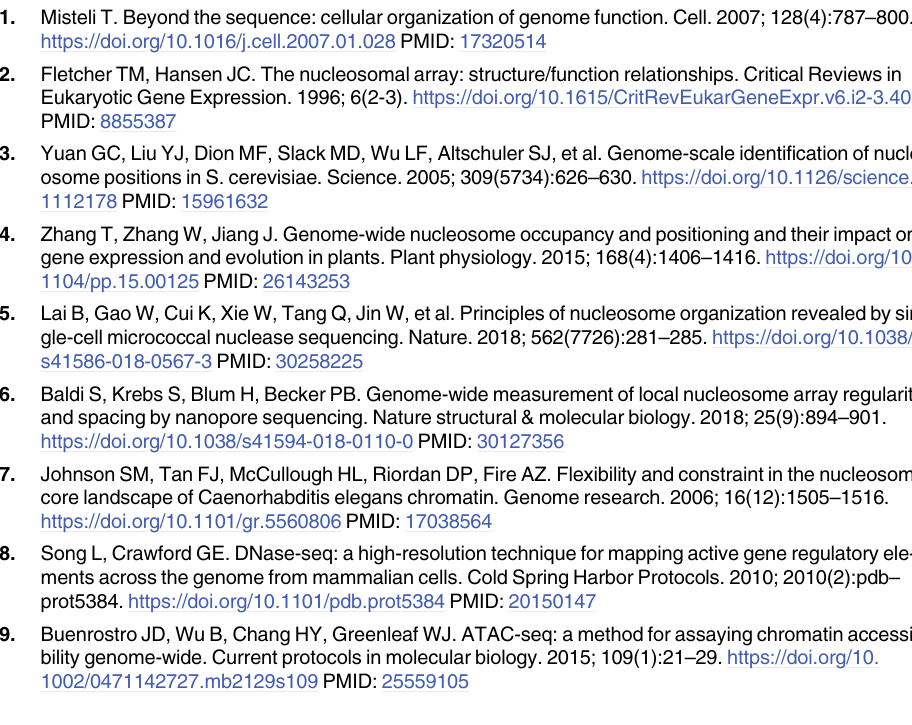
S1 Table. Proportions of tetra-nucleosome motifs in different groups in yeast. S2 Table. F1-scores of different folding motif